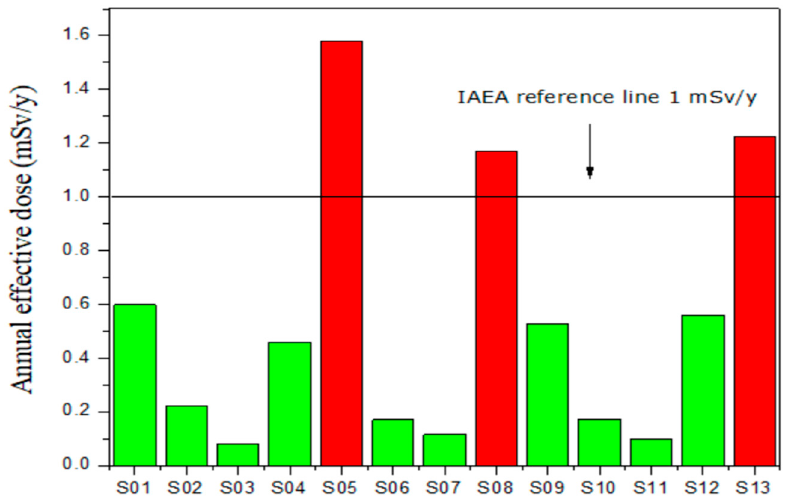
Figure 4. Annual effective dose for 13 undergarment products demonstrating measurable gamma activity.